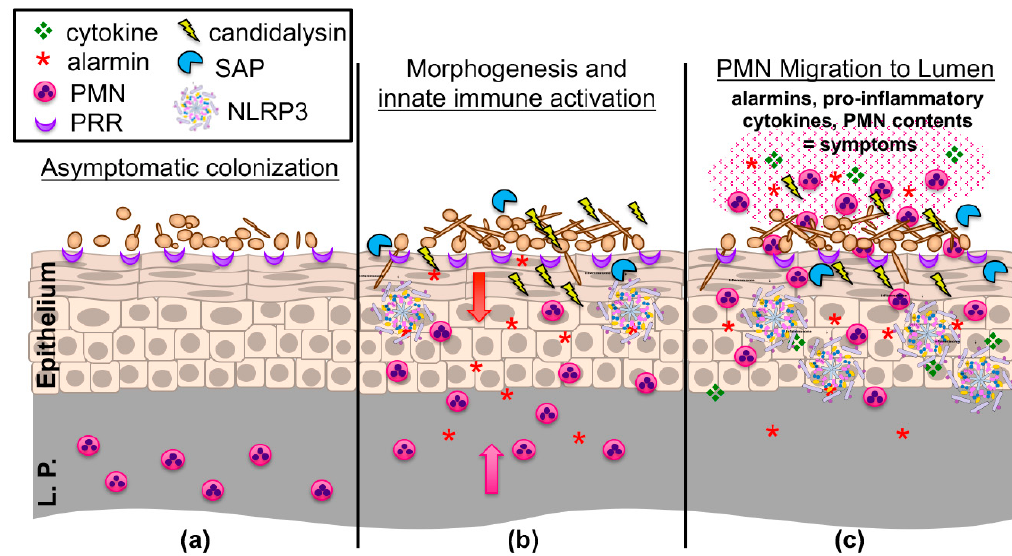
Figure 1. An updated working model of the immunopathogenesis of C. albicans vaginitis. ( a ) Yeast forms of C. albicans asymptomatically colonize the vaginal epithelium despite the presence of numerous pattern recognition receptors (PRR) on the epithelial surface. ( b ) C. albicans begins to undergo the yeast-to-hypha switch under morphogenesis-inducing conditions (e.g., increases in estrogen, elevated vaginal pH, and microbiome disruption). Augmented recognition by PRRs, increased hyphal biomass, expression of hypha-associated virulence factors (candidalysin, secreted aspartyl proteinases (SAPs)) activates NLRP3 inflammasome signaling, eliciting inflammatory cytokines and chemokines (e.g., IL-1 β , S100A8 / 9 alarmins) in the vaginal epithelium, resulting in initial migration of polymorphonuclear leukocytes (PMNs) from the lamina propria (L.P.) to the vaginal lumen. ( c ) Failure to adequately reduce immunopathological triggers results in the continued expression of innate immune e ff ectors by the vaginal epithelium. These initial signals, coupled with the secondary amplification of immune e ff ectors by recruited PMNs, contribute to symptomatic infection and characteristic immunopathology. Figure adapted from: PLoS Pathog . 2014 Apr; 10(4): e1003965 [47].